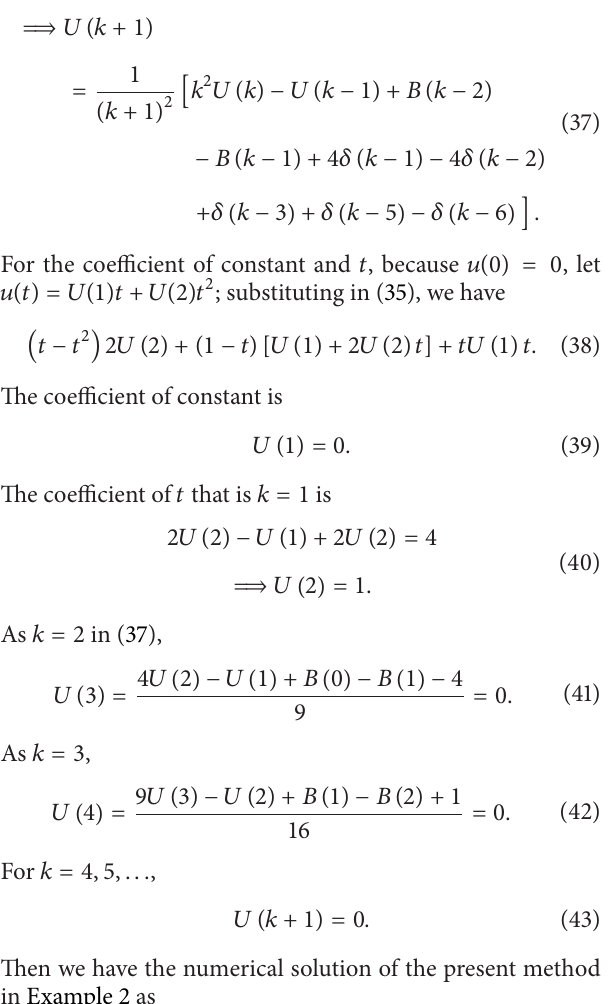
Table 1: Comparison of relative errors of the present method for Example